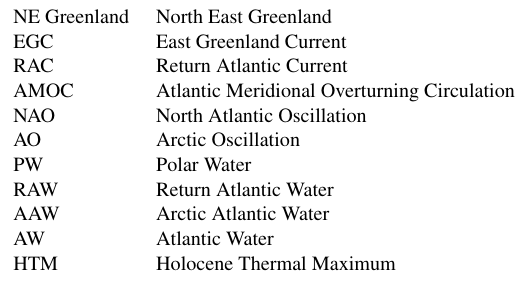
Table A4. List of abbreviations used in the